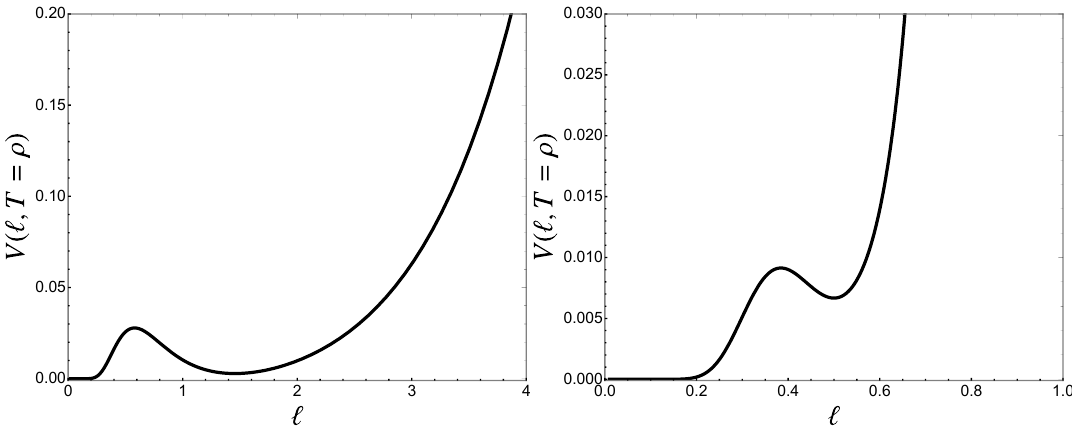
Figure 8 . Plots of the scalar potential evaluated at T = ρ for Example 1 (left) and Example 2